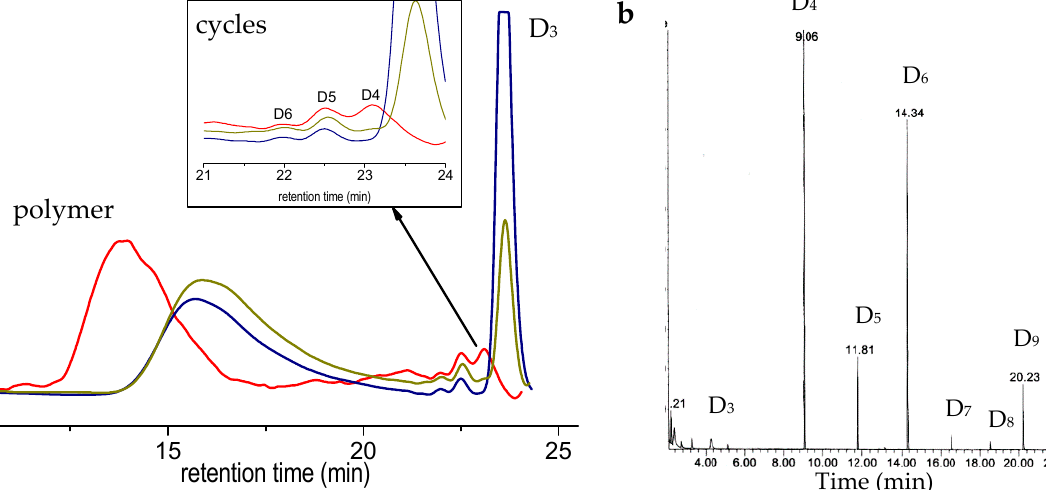
Figure 3. ( a ) SEC chromatograms of samples taken after ½ day (blue curve), 1 day (green olive curve)